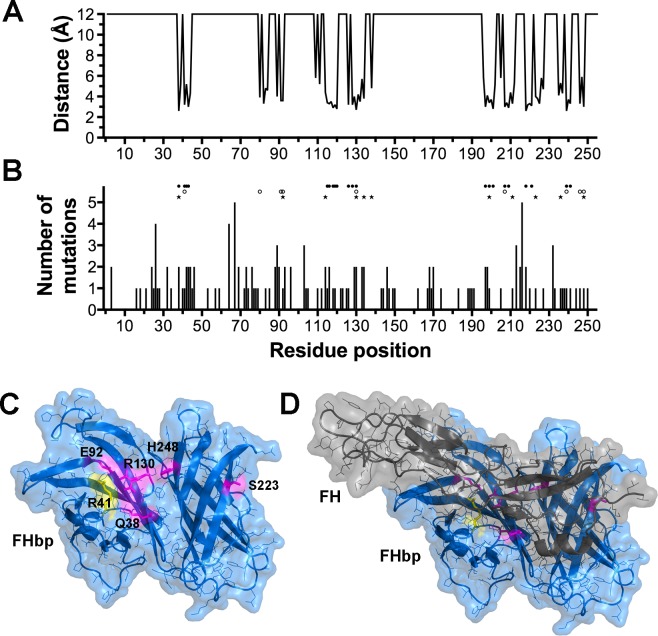
Location of mutations in FHbp in relation to FH.
A. Plot of distance between each FHbp residue and closest atom in FH in the crystal structure of the FHbp-FH complex (PDB ID 2W80) [23]. Distances greater than 6 Å are depicted as 12 Å. The lipidated Cys residue in the mature protein is designated as residue number 1. B. Histogram showing number of mutations at each residue position in FHbp. Above the histogram are the known FH interaction residues (filled circles) [23], residues mutated in previous studies (open circles) [22, 23, 27] and residues mutated in the present study (filled stars). C. Location of residues with mutations identified to decrease binding of FH to FHbp (magenta). The location of residue R41, which previously was identified as an important FH binding residue is shown in yellow. D. Location of FH fragment (grey) relative to residues with mutations identified to decrease binding of FH to FHbp.